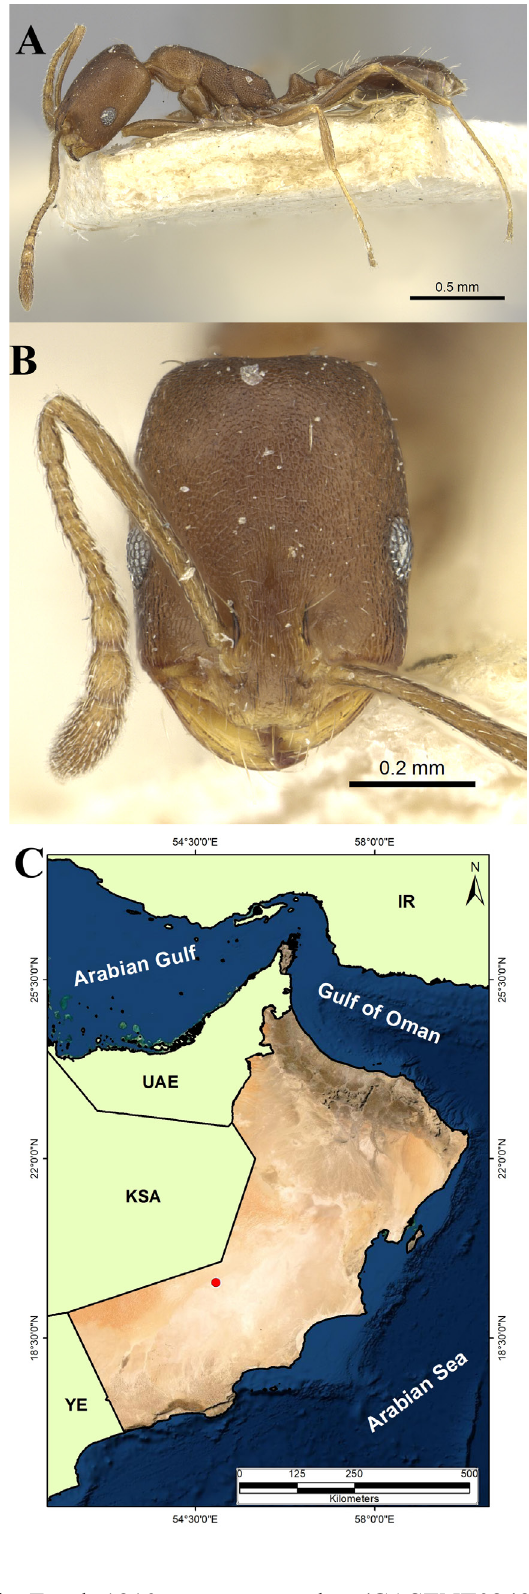
Fig. 36. Monomorium carbo Forel, 1910, syntype, worker (CASENT0249908, AntWeb.org (Shannon Hartman)). A . Body in profile. B . Head in full-face view. C . Distribution